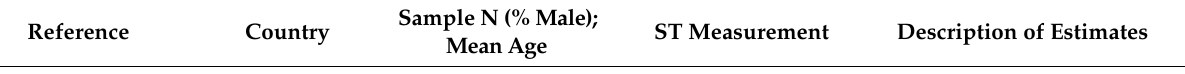
Table 1. Population characteristics, ST measurement, subgroups, and quality of included